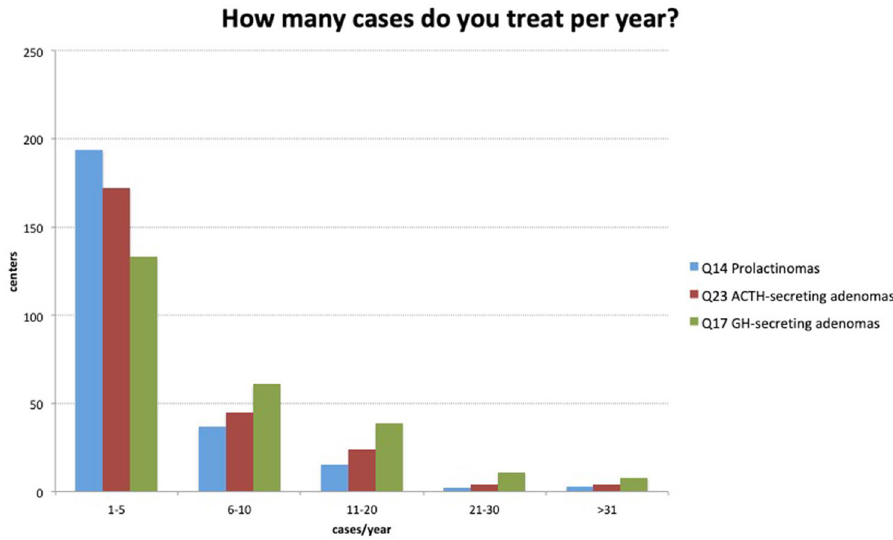
Figure 1. Hormone-secreting adenomas treated per year.